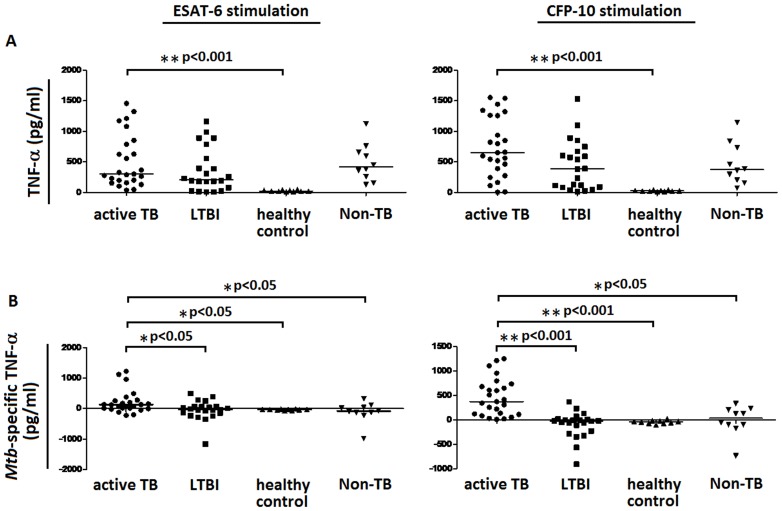
The secretions of TNF-α and Mtb-specific TNF-α by ESAT-6 or CFP-10-stimulated PBMCs.PBMCs obtained from active TB patients (n = 25), LTBI individuals (n = 22), healthy control subjects (n = 10) and non-TB patients (n = 10) were stimulated with ESAT-6 or CFP-10. PBMCs stimulated with medium alone were used as a background control. (A) After 16–20 h of incubation, the supernatant was collected and tested for concentrations of secreted TNF-α by ELISA. (B) Mtb-specific TNF-α was calculated by subtracting background TNF-α secreted by medium-stimulated PBMCs from TNF-α secreted by ESAT-6 or CFP-10-stimulated PBMCs. Median values for each group of participants are represented by a horizontal bar. *p < 0.05, **p < 0.001.